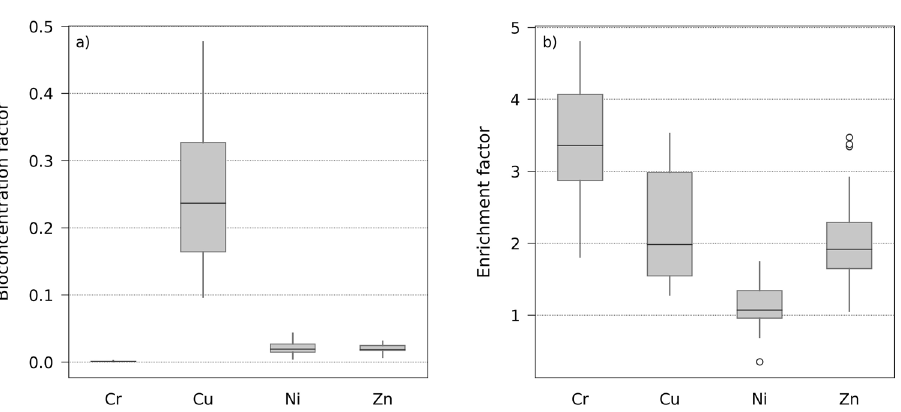
Figure 1. ( a ) Location of the study site on the airborne hyperspectral image acquired with the VNIR-1600 HySpex sensor (R: 647.29 nm, G: 552.77 nm, B: 443.72 nm). This image was generated under Python 3.7.6 ( available at https ://www.pytho n.org/). ( b ) Zoom on the study site. The grey polygon shows the delineation of the brownfield obtained from GPS coordinates data. ( c ) The brownfield during the field sampling campaign. The site is mainly colonized by R. fruticosus L. (bramble), and bordered by tree vegetation. ( d ) Bramble leaves showing slight symptoms of discoloration and red pigmentation on margins.